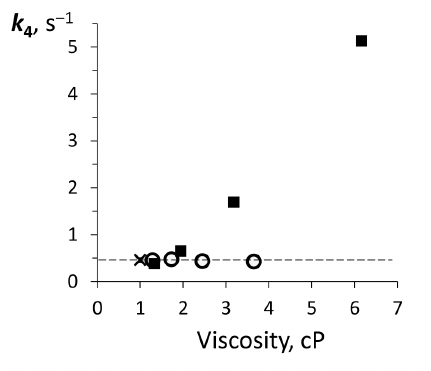
Figure 7. The dependence of catalytic constant of bacterial luciferase ( k 4 ) on viscosity for glycerol (empty markers) and sucrose (filled markers) solutions. The dashed line refers to the value in the buffer solution marked with a